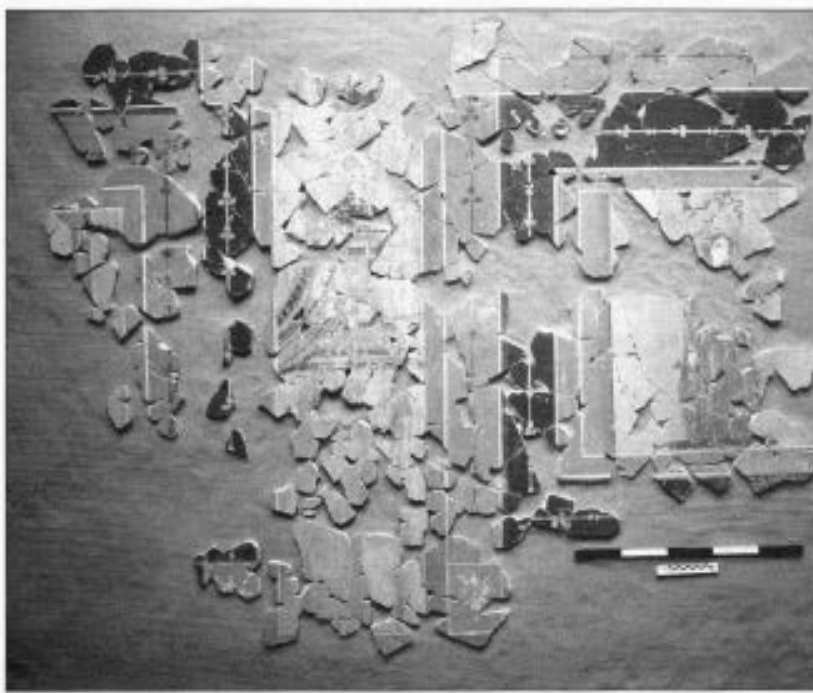
Figure 5 Re-assembled fragments of painted plaster from a Roman house at the site of Sidi Khrebish, Benghazi, Libya, showing part of the design from the main zone of a wall. The design consists of panels outlined in coloured borders and containing figurative and architectural detail (in the so-called Pompeian fourth style). The pigments used include red and yellow ochres, green earth, Egyptian blue and the optical blue obtained by mixing carbon black and a white.